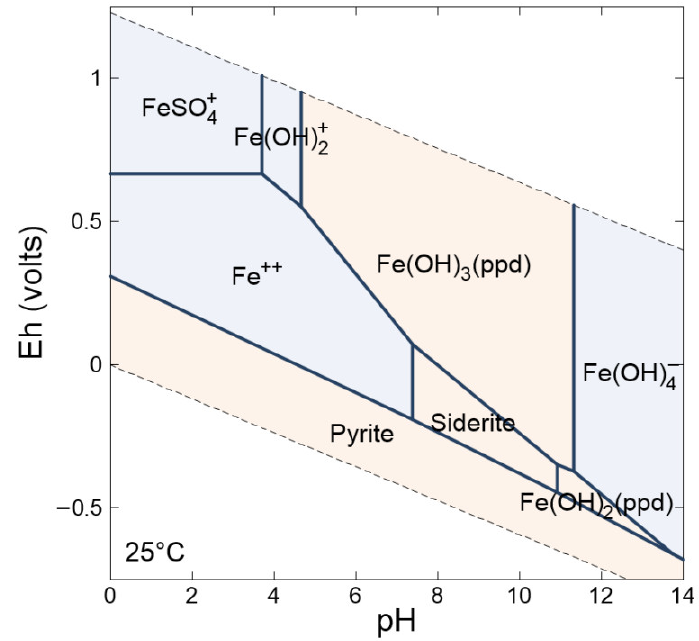
Figure A27. Low iron 0.2 mg/L, Ca 5 mM (200 mg/L), bicarbonate 7 mM (427 mg/L), sulfate 4 mM (384 mg/L), and chloride 2 mM (71 mg/L).